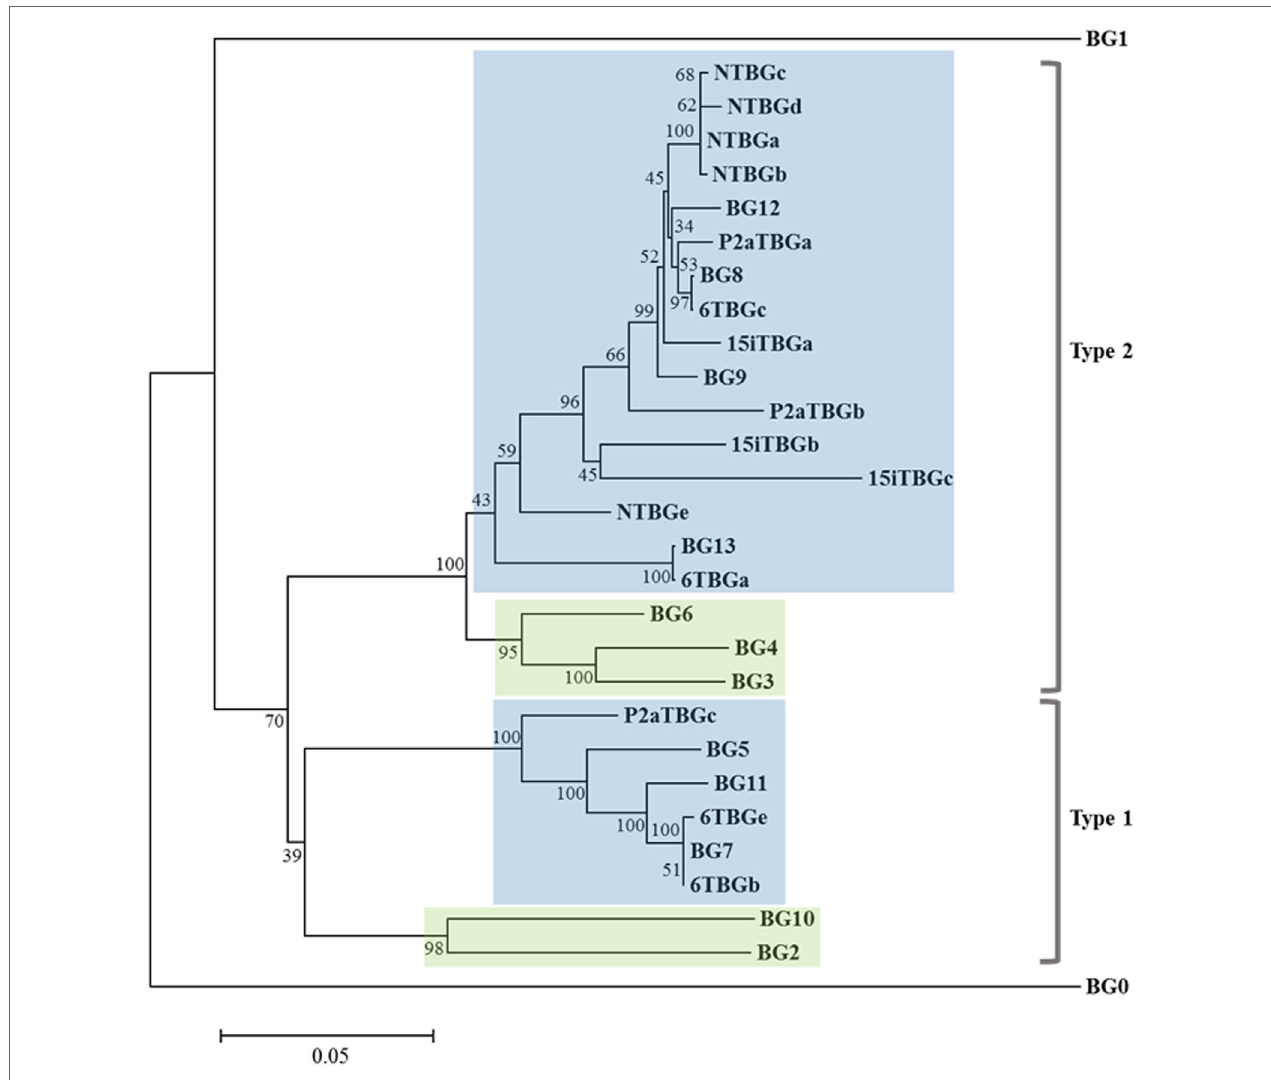
FigUre 3 | Phylogenetic tree of nucleotide sequences for the “(nearly) full-length conceptual transcripts” (i.e., exons without introns) for the 16 genes from four chicken lines identified in this paper, and for the 14 BG genes of the B12 haplotype from Ref. (24). Names of the transcripts follow the convention: abbreviated line name, “T” for T cells, “BG” and the letter “a” representing the most frequently detected clone from the most frequently detected exon 2 sequence (and “b” representing the most frequently detected clone from the second most frequently detected exon 2 sequence, and so forth). Names of the genes follow the convention “BG” and the number of the gene locus from the B12 haplotype. Indicated by color are those clades with 5 ′ ends of hemopoietic (blue) and tissue (green), and by brackets for 3 ′ ends of type 1 and type 2. Branch lengths are scaled by genetic distance, and percentage bootstrap values are indicated at the nodes. 6TBGd is not present in this tree since it was only detected by the SS–TM amplification, and some sequences may be due to nucleotide mis-incorporation during amplification (for instance, NTBGa may have given rise to NTBGb and NTBGc, see Figure S1 in Supplementary